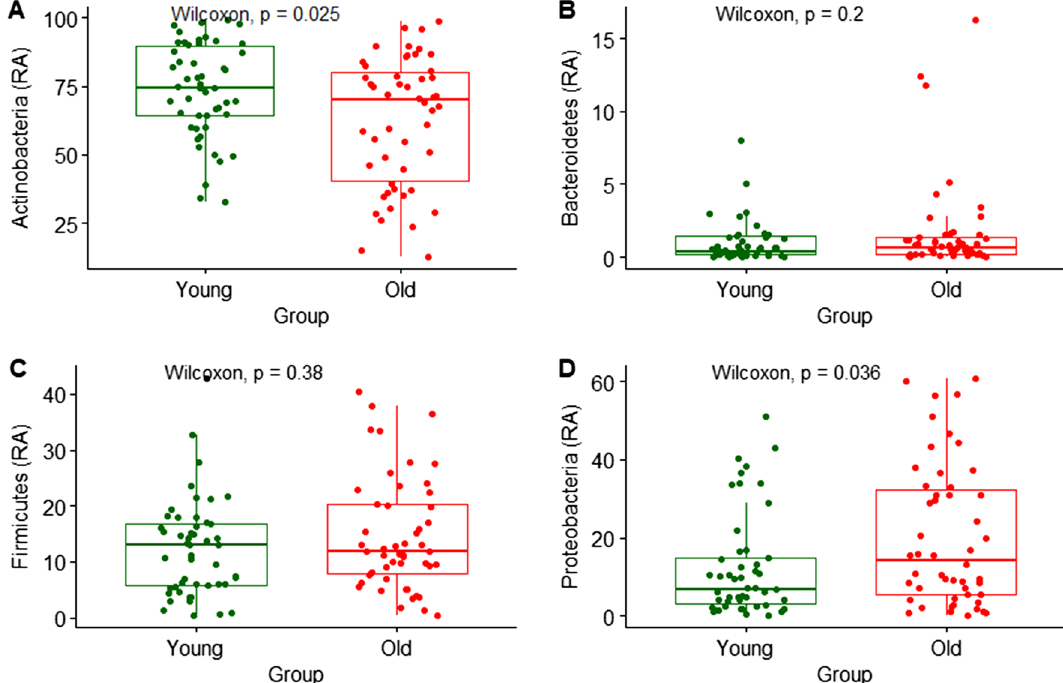
Figure 3. Relative abundance (%) of four dominant phyla in skin samples between younger (young) and older (old) group. ( A ) Actinobacteria; ( B ) Bacteroidetes; ( C ) Firmicutes; ( D ) Proteobacteria. Wilcoxon signed-rank test was used for statistical analysis. P values are displayed in the figures.